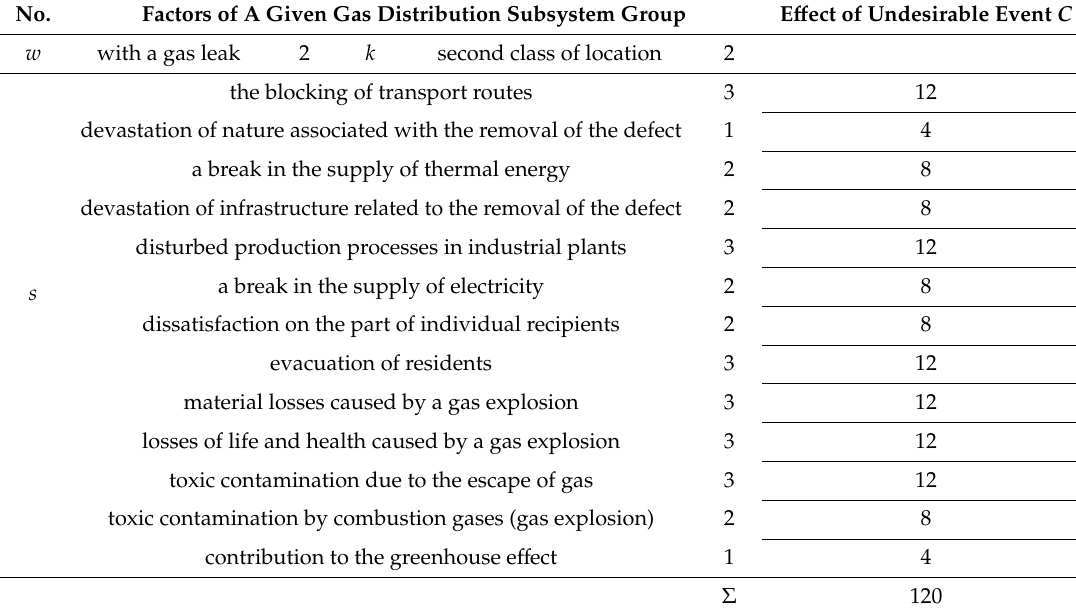
Table 2. Characteristics of the gas network under analysis concerning the e ff ect of an undesirable event. No. Factors of A Given Gas Distribution Subsystem Group E ff ect of Undesirable Event C